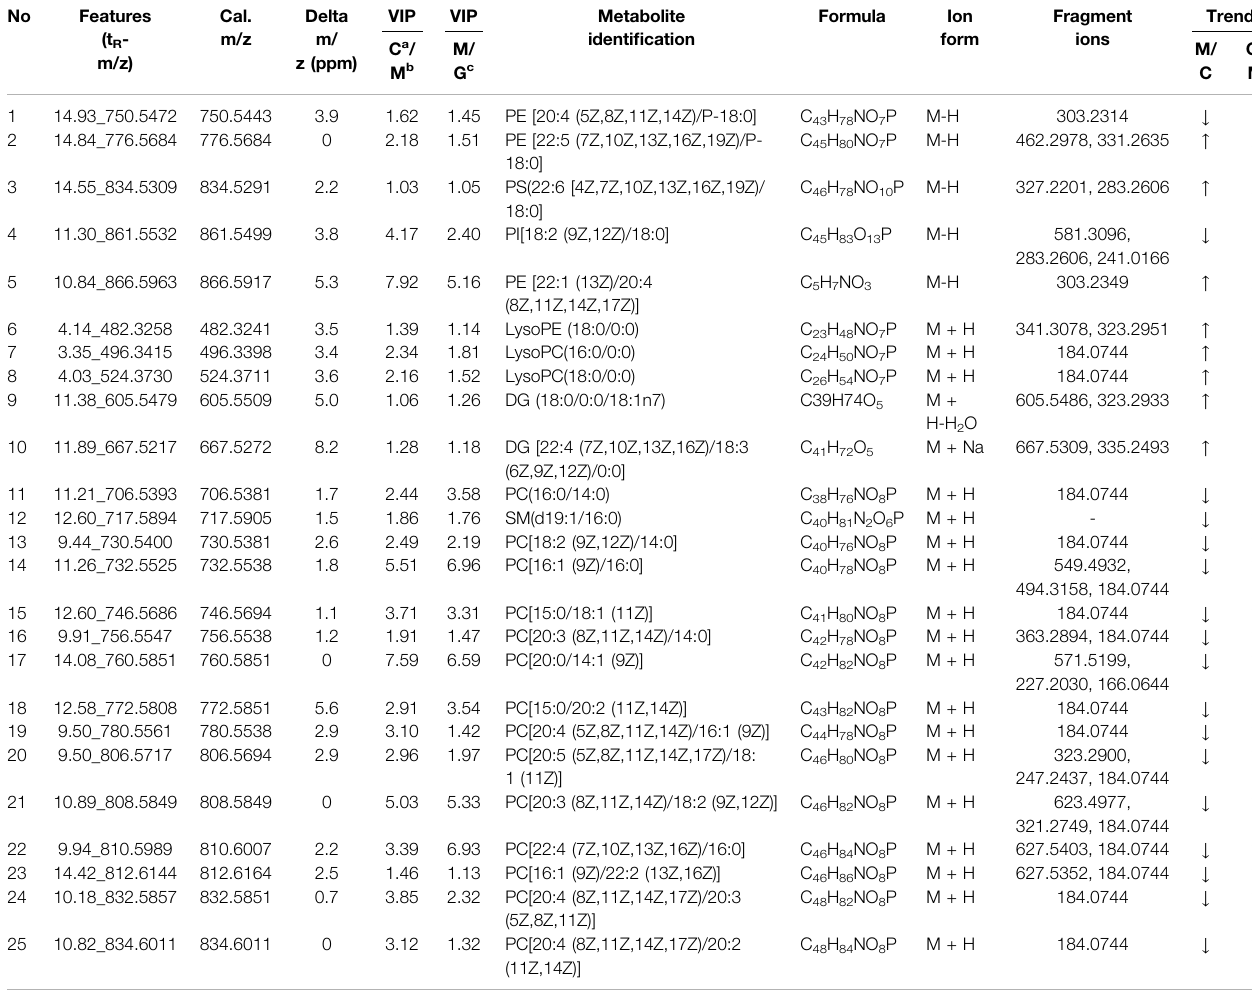
Formula Ion Fragment form ions